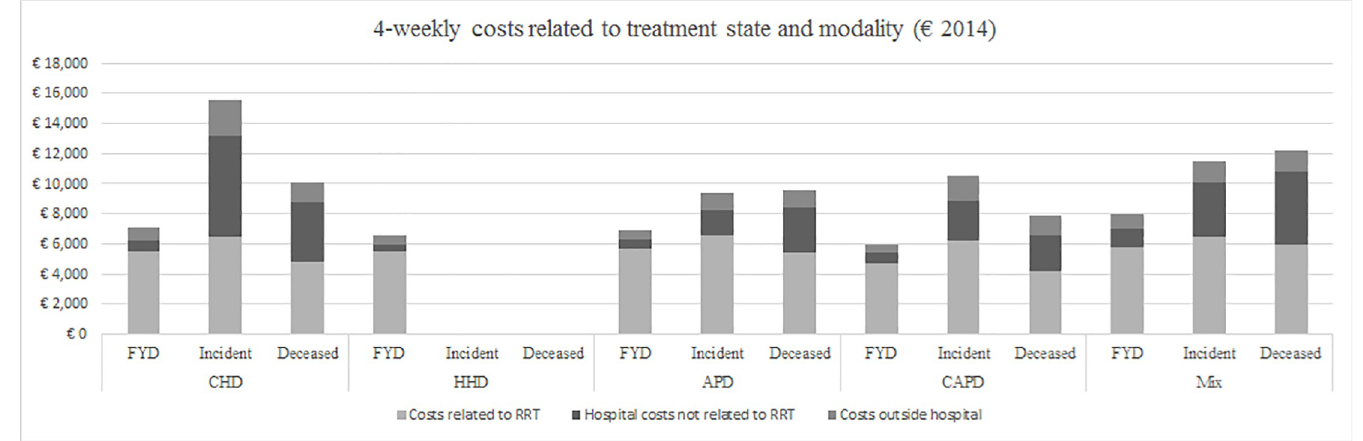
Fig 2. 4-week average mean healthcare costs related to treatment states, per modality. Note: FYD = full year on dialysis; Incident = incident patients starting treatment in 2014; Deceased = patients who died in 2014; CHD = Centre Haemodialysis; HHD = Home Haemodialysis; APD = Automated Peritoneal Dialysis; CAPD = Continuous Ambulatory Peritoneal Dialysis; Mix Group = dialysis modality changed in 2014.